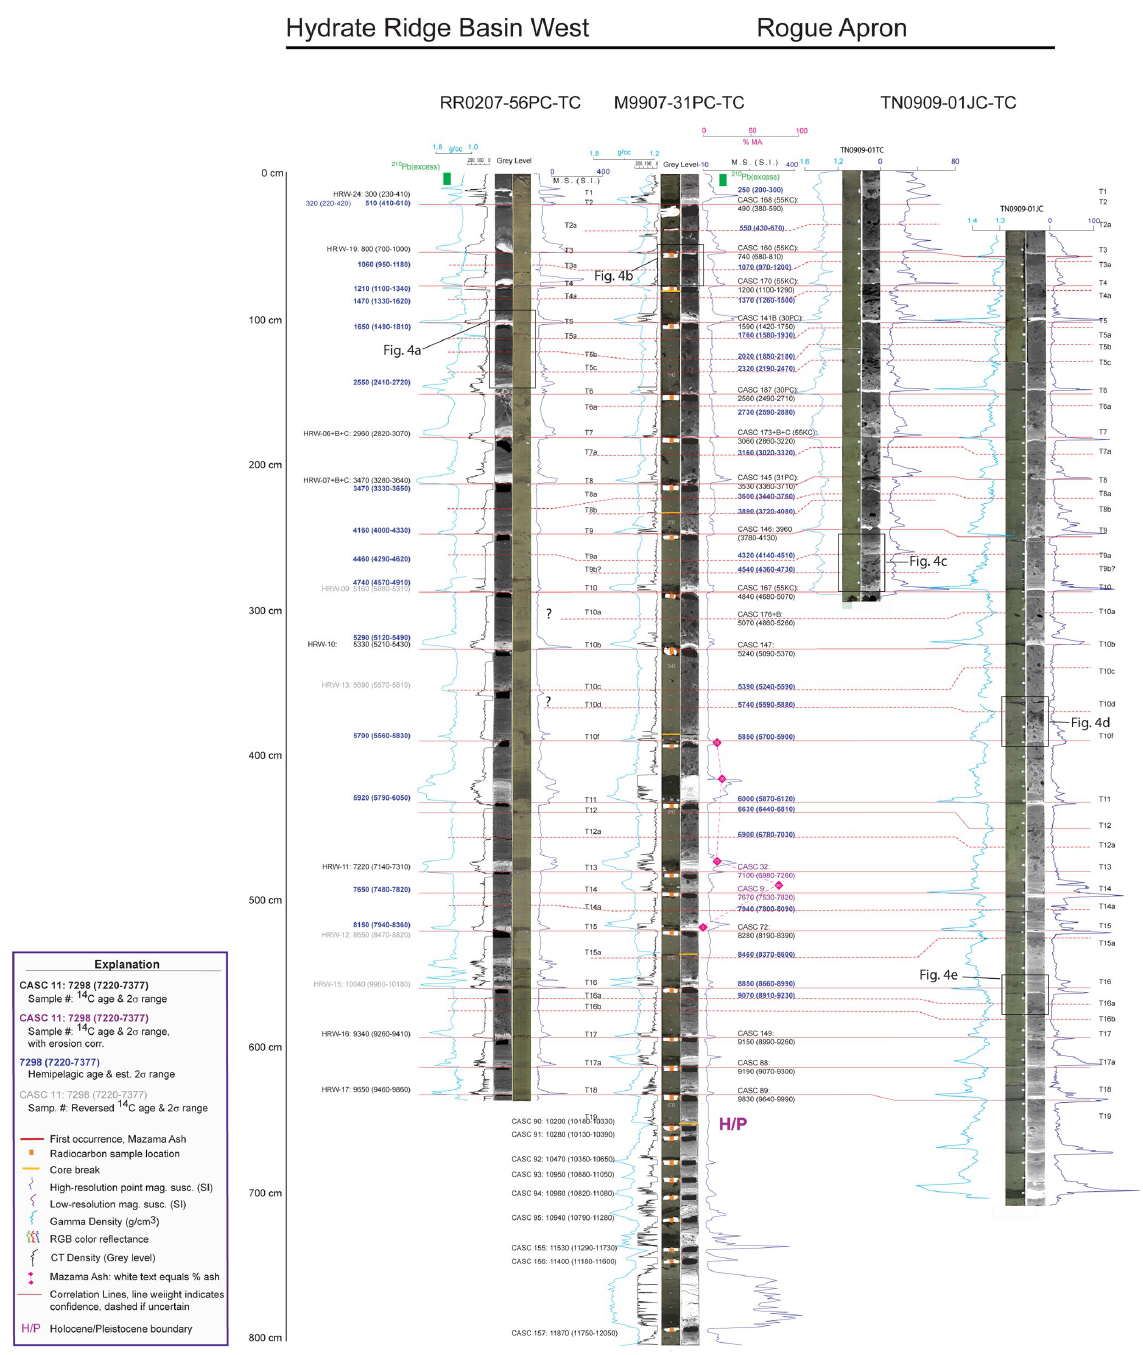
Fig. 3. CT, visible imagery and physical properties from the Hydrate Ridge and Rogue Apron cores, central-southern Cascadia margin. Data from HR cores 56 PC-TC and Rogue cores 31PC-TC are each summarized with a single composite of piston and trigger cores, all 14 C ages from each site are plotted on the representative core. These two cores are “flattened” (rescaled with event bases and tops aligned) with Rogue core 31PC at true scale. Undated Rogue Apron core TT0909-01JC also shown flattened to 31 PC-TC. Correlation between sites based on stratigraphic methods described in text, 14 C data, Mazama ash and Holocene/Pleistocene boundary datums. Black boxes indicate locations of enhanced images in Fig. 4. Higher confidence shown by heavy lines, lower confidence with dashed lines, lowest confidence with queried dashed lines. The two sites are 250km apart and are isolated from each other. Hydrate Ridge is isolated from terrestrial and shallow water sediment